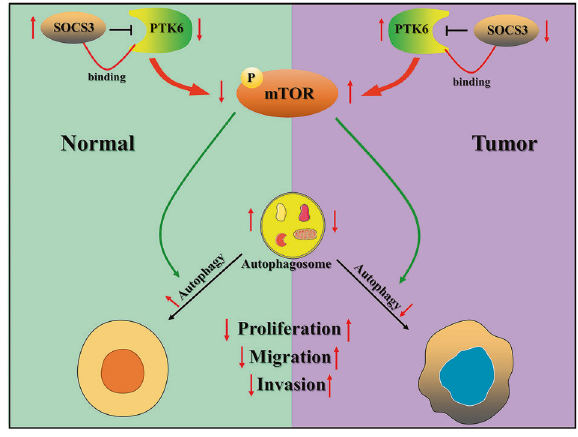
Fig. 9 Proposed schematic illustration of the PTK6 mechanism: PTK6 inhibits autophagy to promote UM tumorigenesis by binding to SOCS3 and regulating mTOR